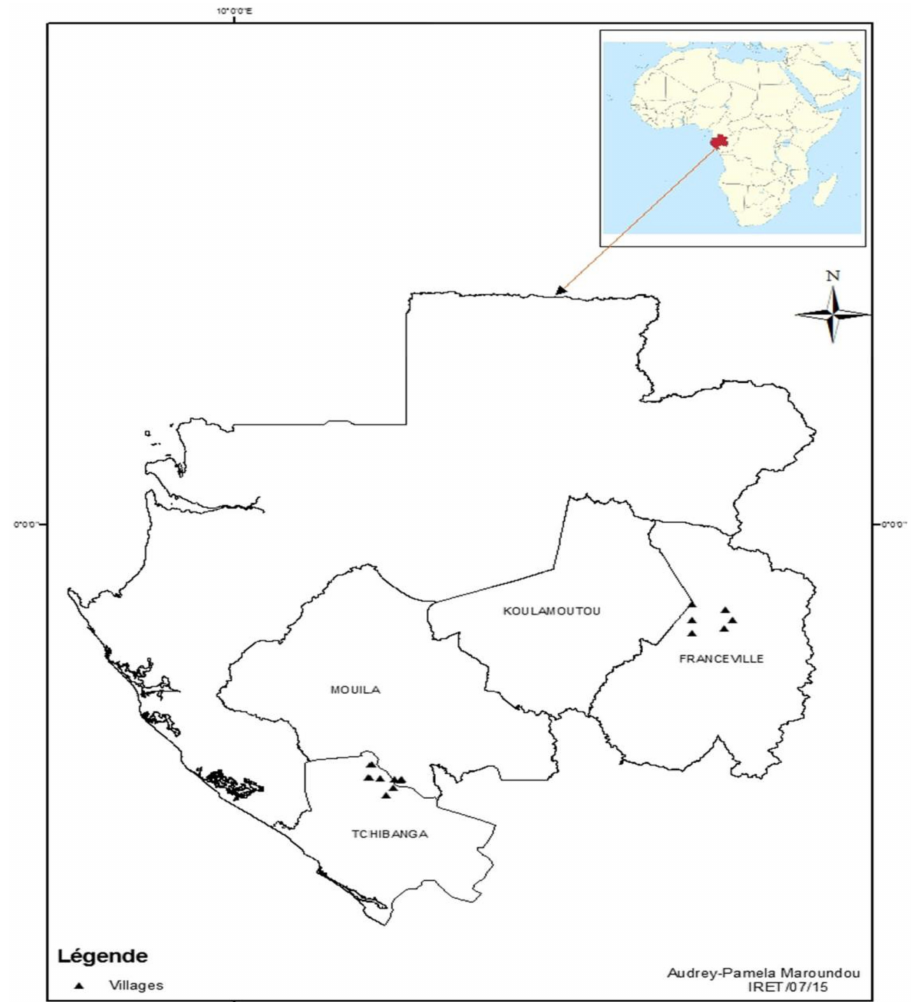
Figure 1. Study villages in two regions of the two timber